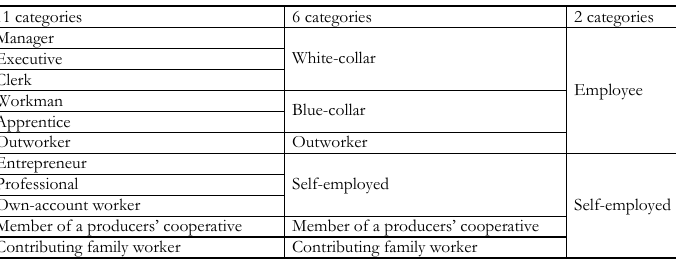
Scheme of categories aggregation process: professional